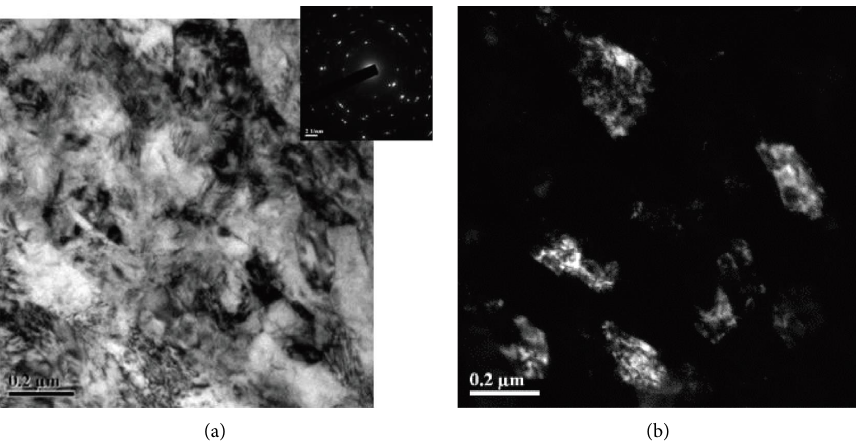
Figure 13: Microstructure of the rolled billet after the third stage of deformation (heating 385 ° S , cross rolling of the sample, h � 1.2mm): (a) bright-feld image and microdifraction; (b) darkfeld